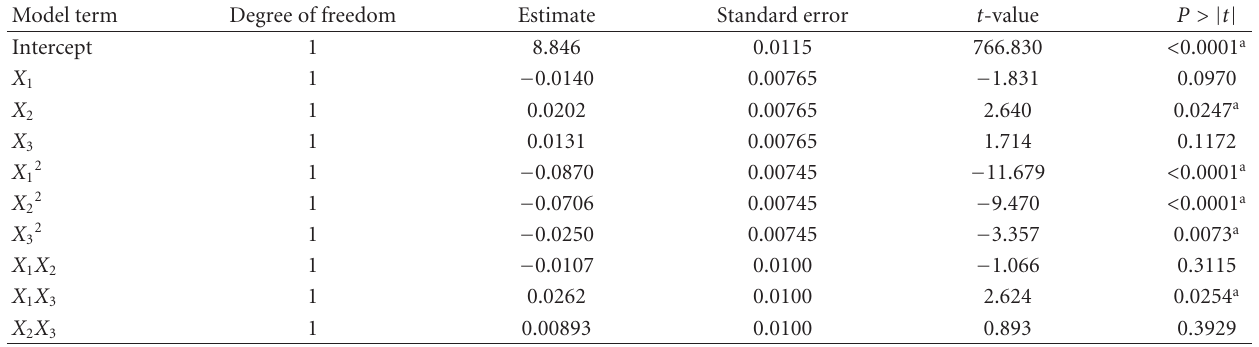
Table 6: E ff ect estimates for the second-order polynomial model.